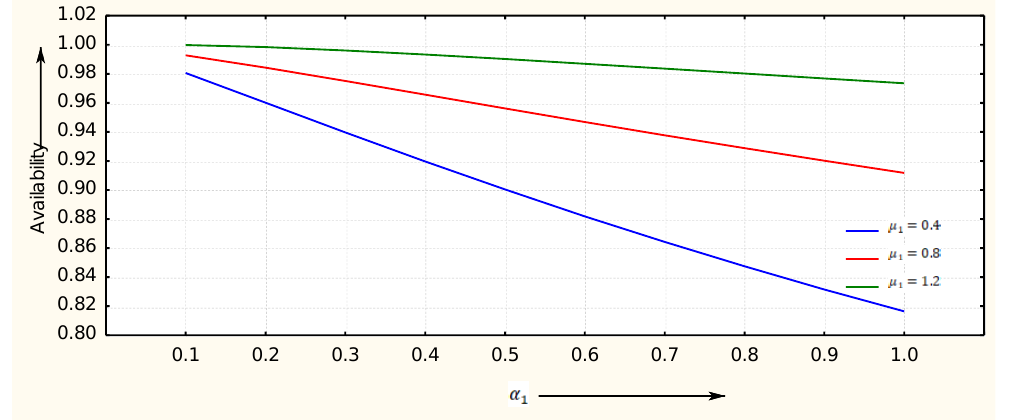
Figure 6. Behaviour of availability w.r.t. 𝛼